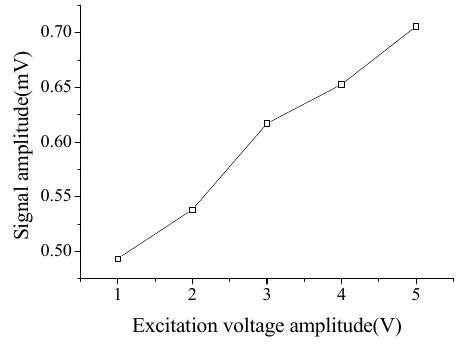
Figure 9. Relationship of signal amplitudes between the output and the input excitation voltage at the intact location of the B ‐ type specimen.